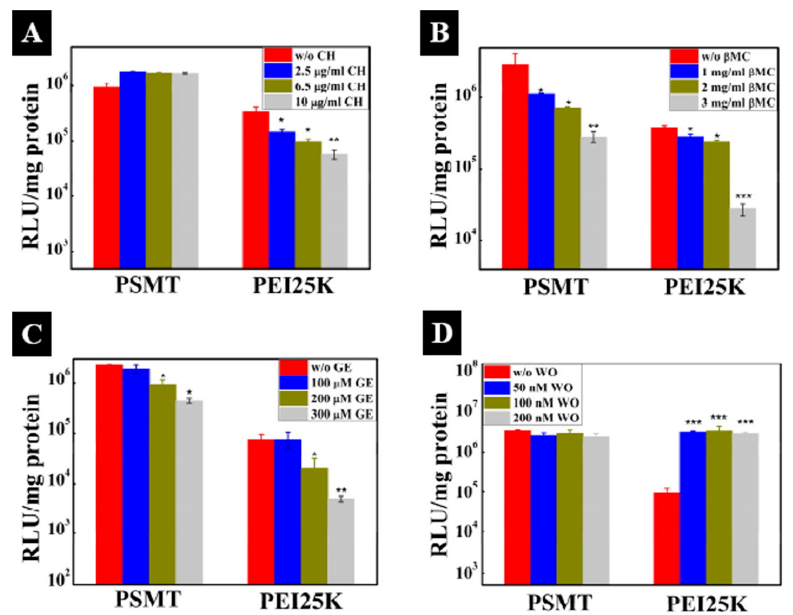
Figure 7. Effects of ( A ) chlorpromazine, ( B ) β -methyl cyclodextrin, ( C ) genistein and ( D ) wortmannin on transfection efficiency in A549 cells. Reproduced with permission from [116]. Copyright proceedings from the American Chemical Society.